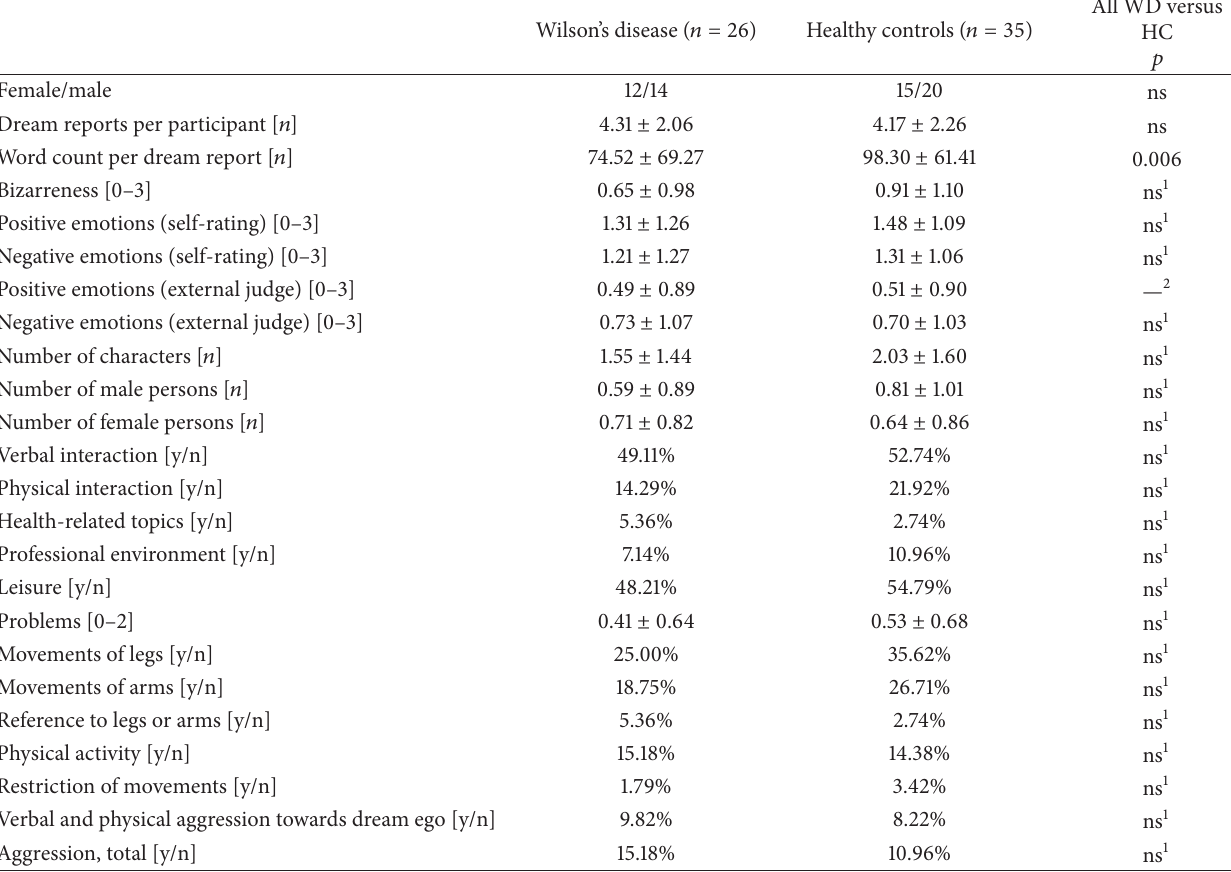
Table 3: Self-rated dream emotions and dream content analysis by external judge; Wilson’s disease versus healthy controls (mean ± SD and